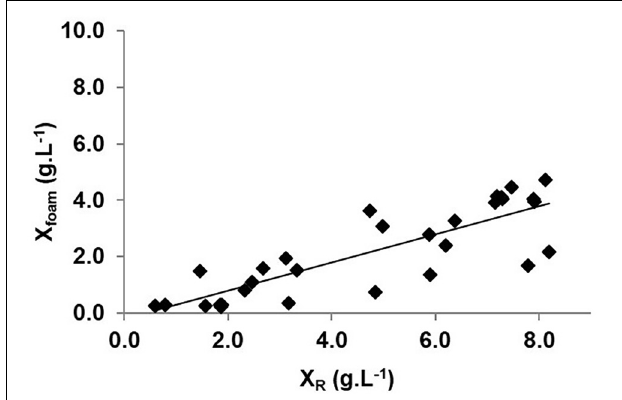
FIGURE 4 | Evolution of biomass concentration in the foam ( X foam ) as a function of biomass concentration in the stirred tank reactor ( X R ) expressed in g(DW) · L − 1 .